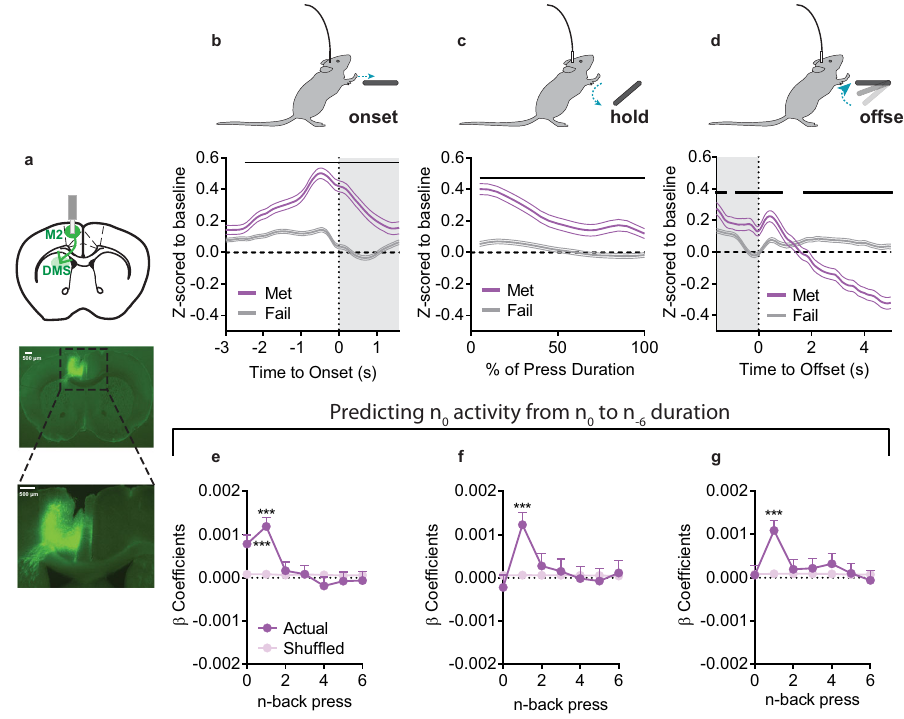
Fig. 5 M2-DMS Ca 2 + activity encodes preceding and upcoming actions. a (top) Schematic and (bottom) example histology of projection speci fi c M2- DMS Ca 2 + fi ber photometry. b – d Ca 2 + activity z-scored relative to baseline and aligned to ( b ) press onset, ( c ) the duration of the press, and ( d ) press offset. e – g β coef fi cients from LME models relating activity to current and prior durations for Actual and Shuf fl ed data ( e ) before press onset, ( f ) during the press, and ( g ) after press offset. Met = Presses that met criteria. Fail = Presses that did not meet criterion. Grey shading in ( b , d ) indicates 1.6 s. Black lines in ( b – d ) indicate signi fi cant differences between Met/Fail via permutation testing that required consecutive samples to pass the threshold for signi fi cance. All tests were two-tailed, and ( e – g ) were corrected for multiple comparisons. Shuf fl ed data are the mean + SEM of 1000 order shuf fl ed β coef fi cients. *** p < 0.001. See also Supplementary Fig. 4, Supplementary Table 5, and Source